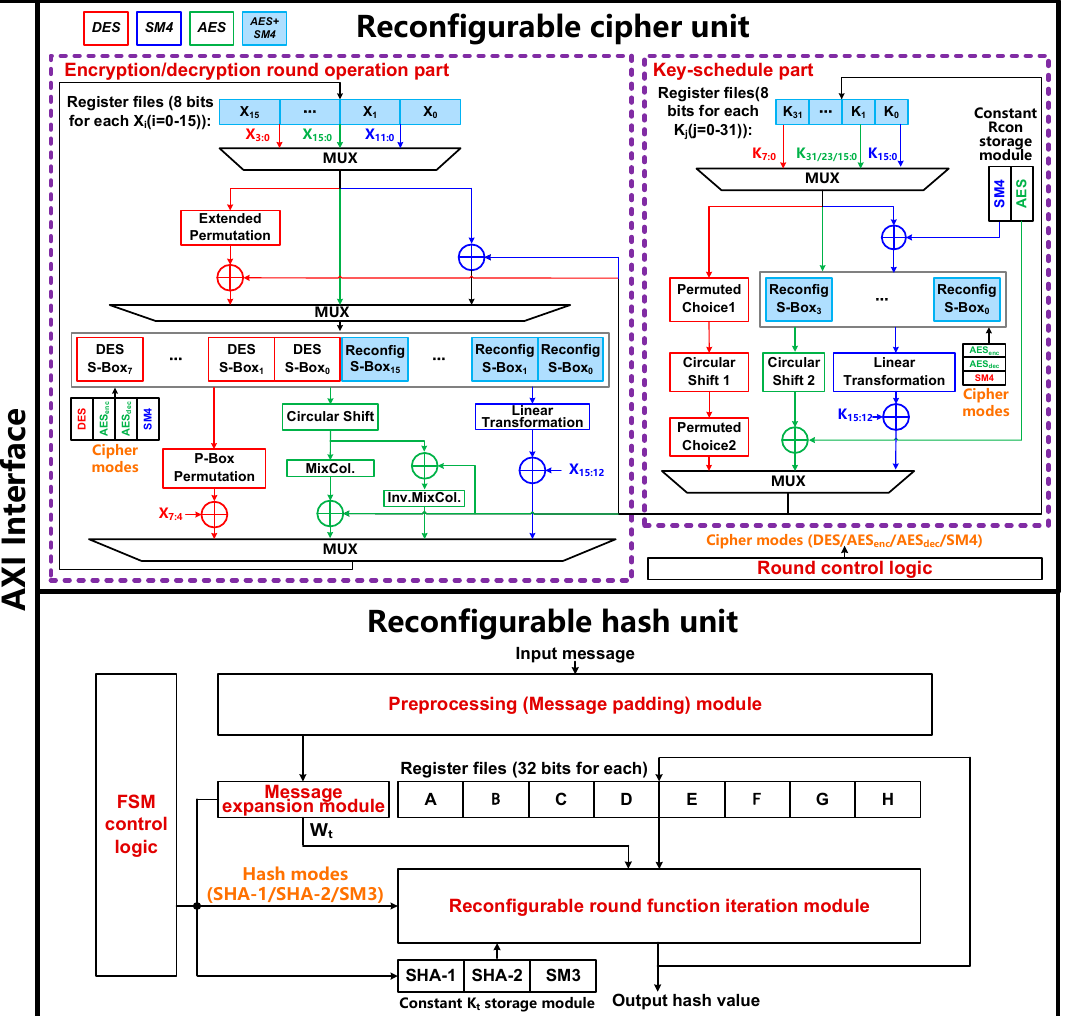
Figure 5. The proposed reconfigurable cryptographic accelerator with reconfigurable cipher unit and reconfigurable hash unit integrated with a unified AXI interface.